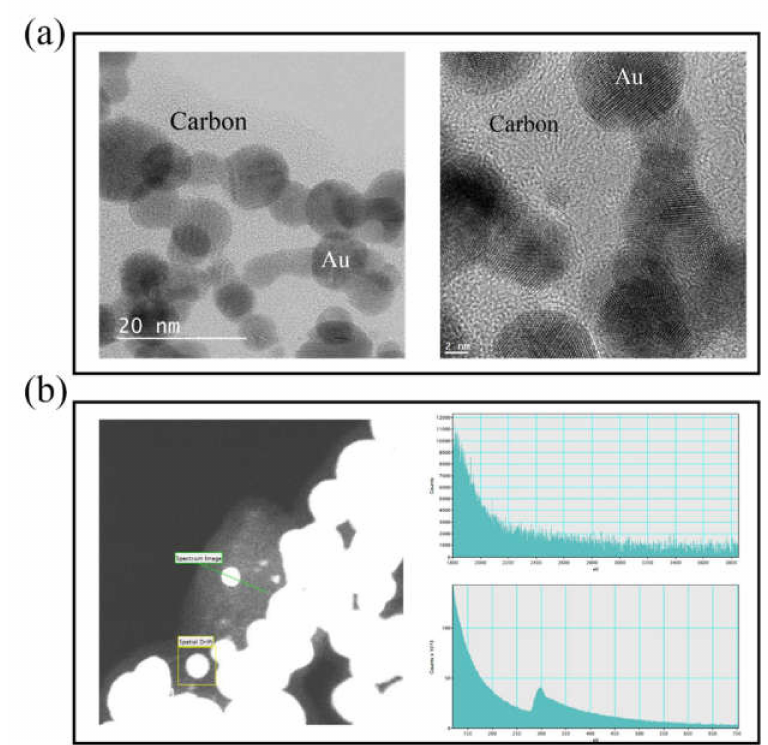
Figure 6. ( a ) HRTEM images of pectin-capped AuNPs encapsulated in carbon nanosheets and ( b ) corresponded energy-loss spectroscopy (EELS) analysis indicating the presence of Au and